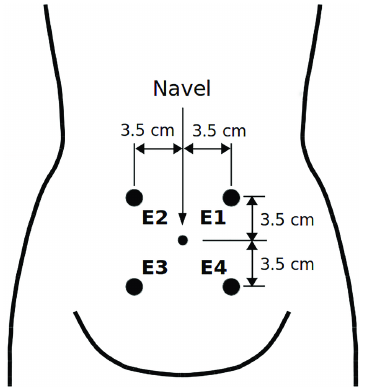
Figure 2. The placement of EHG electrodes, adopted from